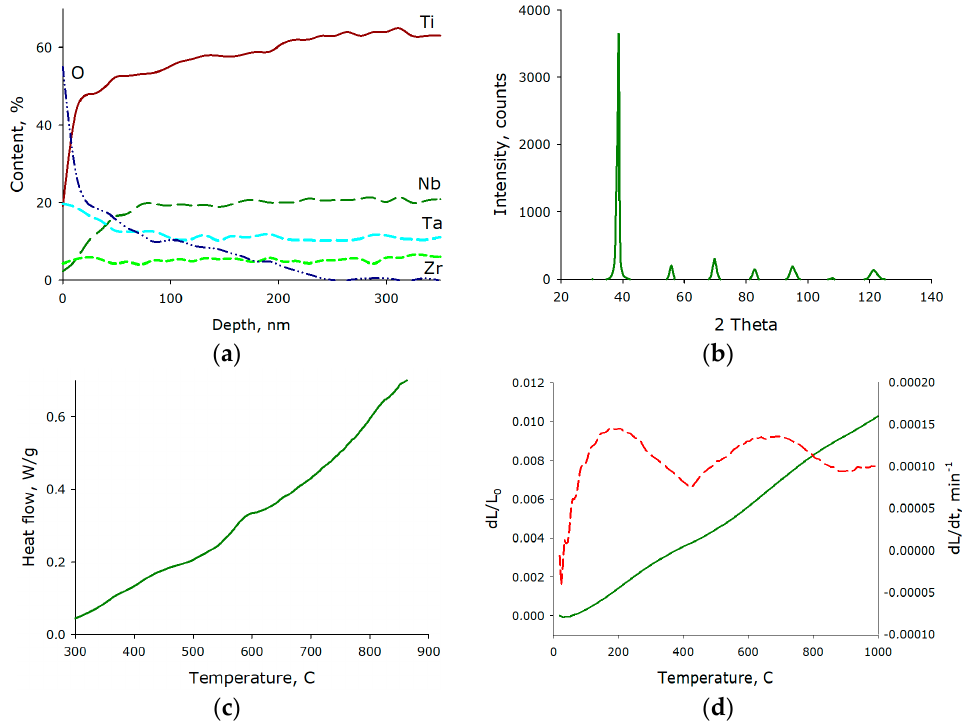
Figure 1. Physical features of Ti-20Nb-10Ta-5Zr alloy: ( a ) element composition; ( b ) X-ray phase analysis; ( c ) function heat flow from temperature; ( d ) results of dilatometric analysis of the alloy. The red line is the left y-axis, the green line is the right y-axis.